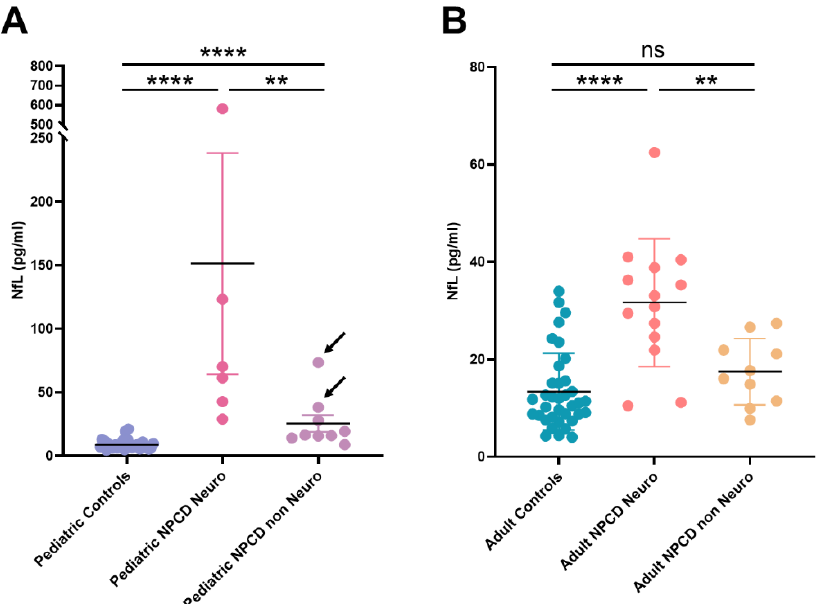
Figure 2. NfL concentration in plasma from neurological and non-neurological NPCD patients. ( A ) Pediatric patients. Arrows indicate NPCD patients affected by the EISL phenotype. ( B ) Adult patients. **** p < 0.0001; ** p < 0.01; NS: